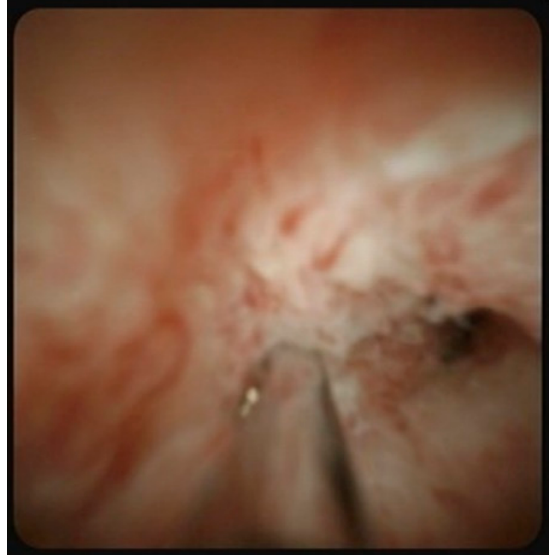
Figure 1. Targeted biopsy under direct vision of peroral cholangioscopy in a case of suspected bile duct cancer.